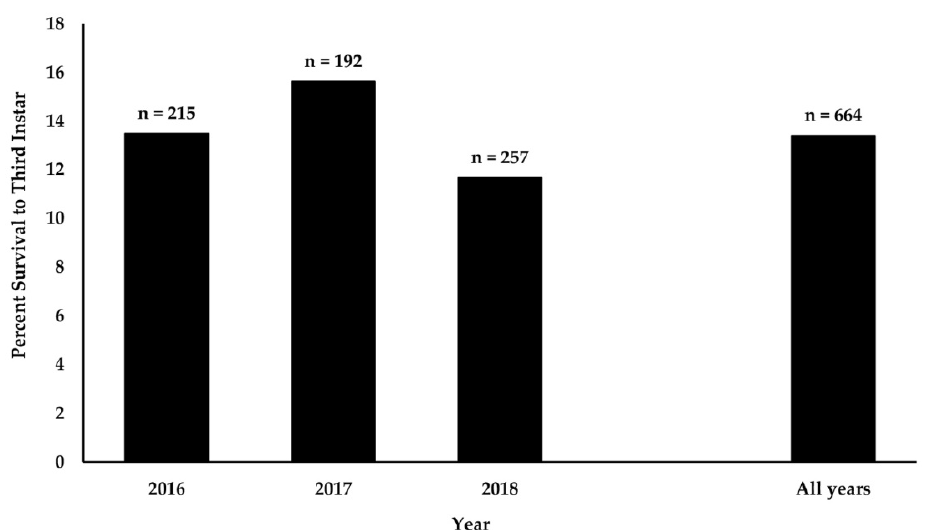
Figure 1. Percent survival of monarch eggs to third instar for each year of the study and for all years combined. Statistical analyses show that differences among years were minor. Chi-square test, 2 × 3 contingency table, Chi-square = 1.48, df = 2, p = 0.477. Numbers over bars indicate the number of eggs included in the